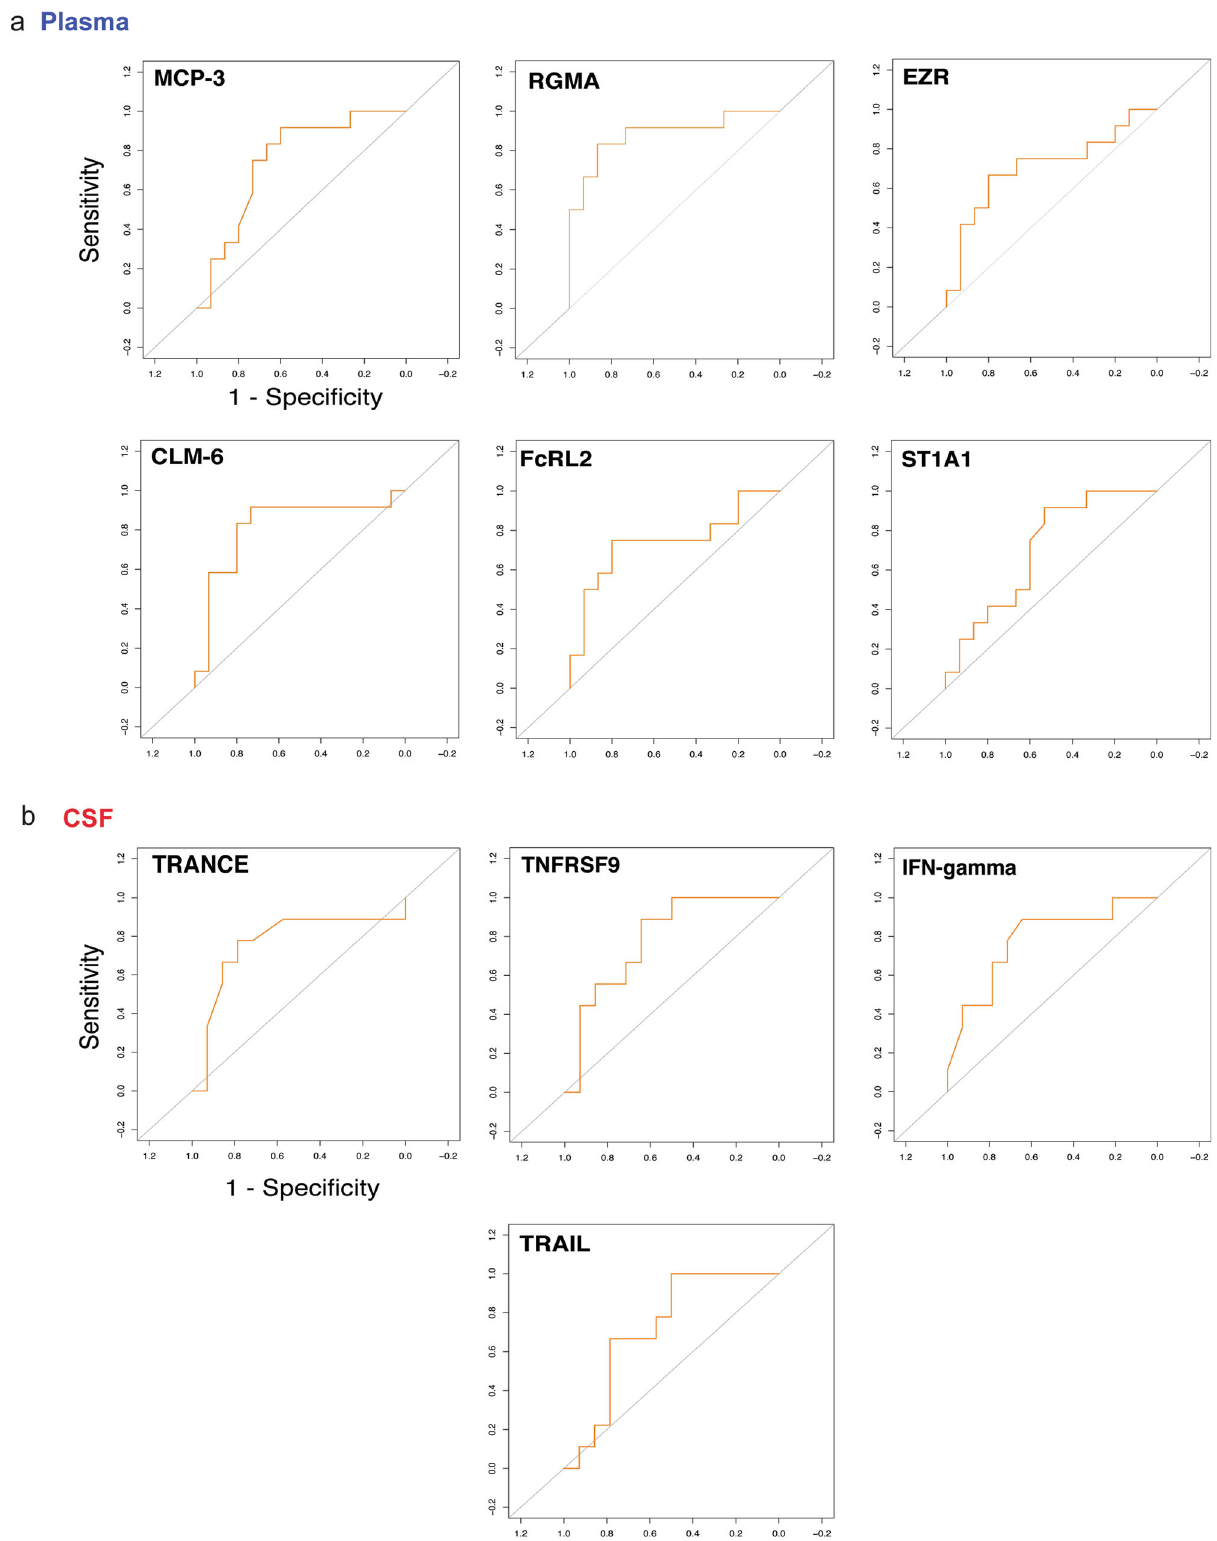
Fig. 8 | Speci fi c CSF and plasma mediators have high predictive value to fore- cast long-COVID. ROC-AUC analysis of CSF and plasma parameters and long- COVID. The Y-axis represents the sensitivity, the X-axis represents the 1-Speci fi city (represented for plasma MCP-3). a Assuming an AUC cut-off of >0.75 for single mediators, high MCP-3 and CLM-6, as well as low RGMA plasma levels were pre- dictive for long-COVID. Confusion matrix analysis of predictive plasma proteins